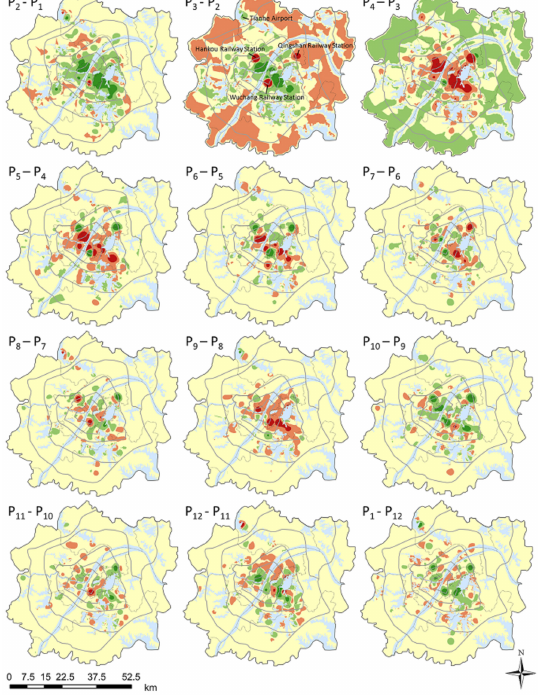
Figure 10. Distribution of the population in Wuhan